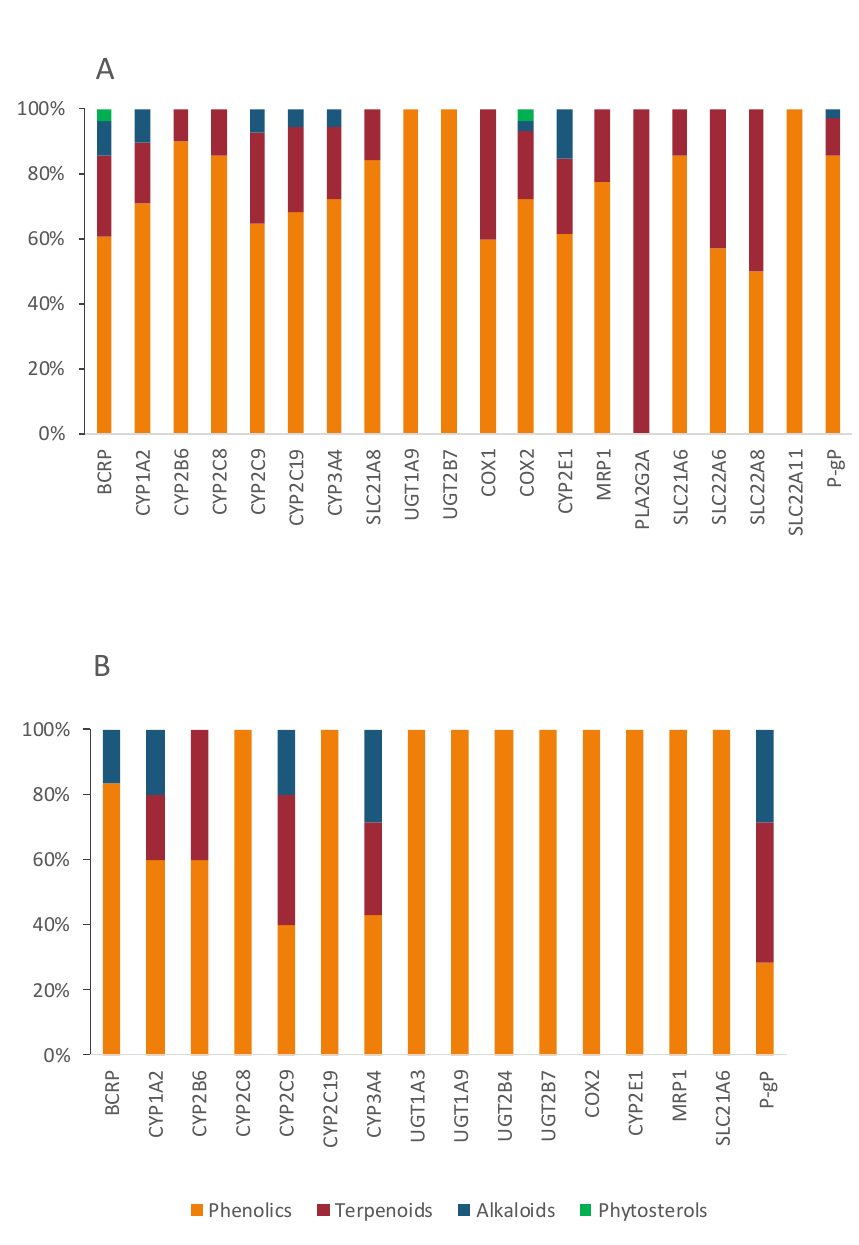
Figure 11. Characterization of the bioactives inhibiting ( A ) or inducing ( B ) Di shared targets, according to chemical class.